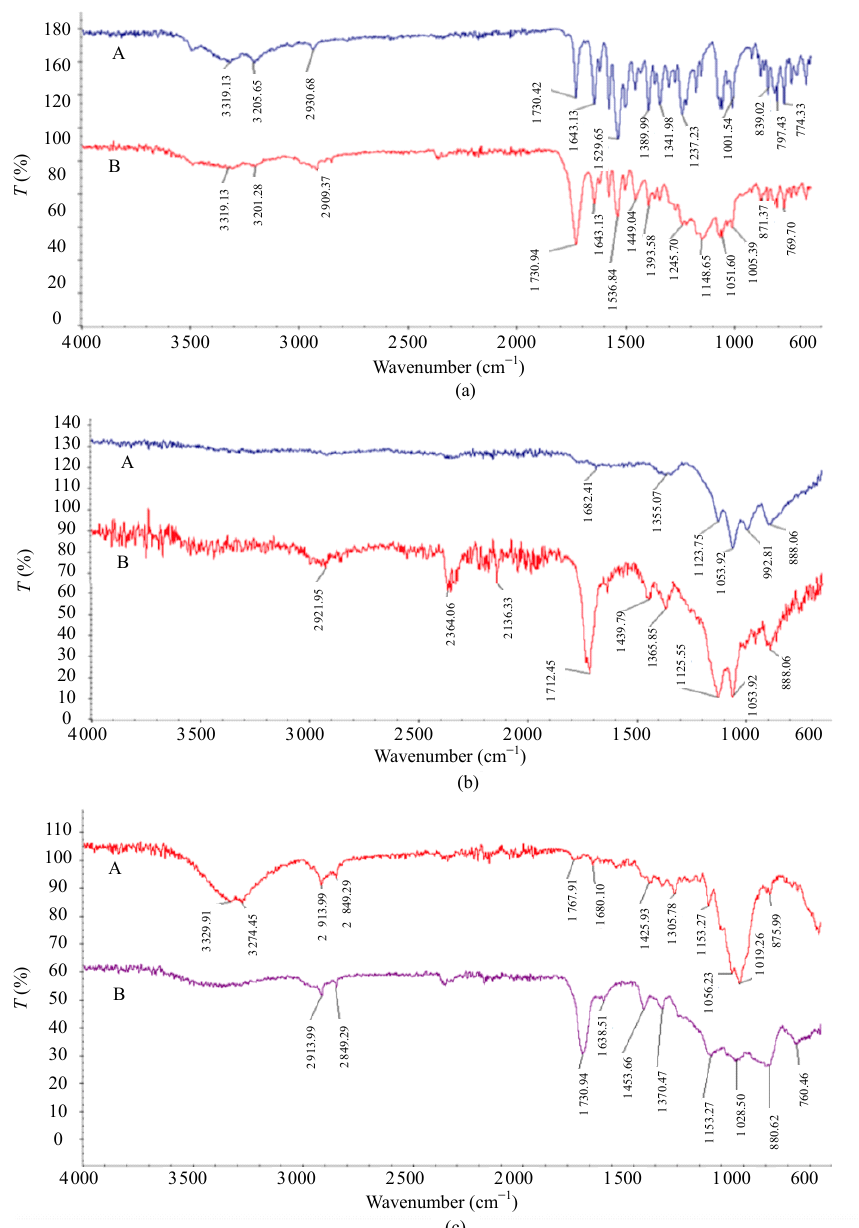
Fig. 3 FTIR-ATR spectra of (a) vitamins B2, (b) B9, and (c) B12 imprinted (A) and non-imprinted (B) films onto the chip surface. The bare gold surface and vitamins B2, B9, and contact angle measurements. The water B12 imprinted SPR chips were characterized by